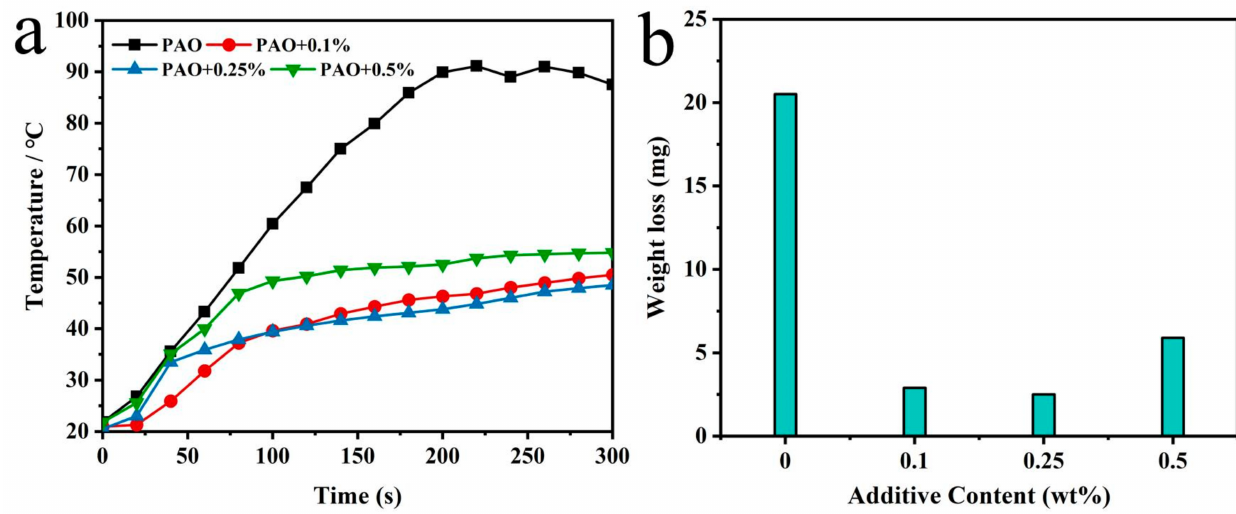
Figure 13. ( a ) IF–WS 2 with different contents and curve of oil temperature changing with working time. ( b ) Weight loss profiles (un-constant temperature, load 980 N, working time 5